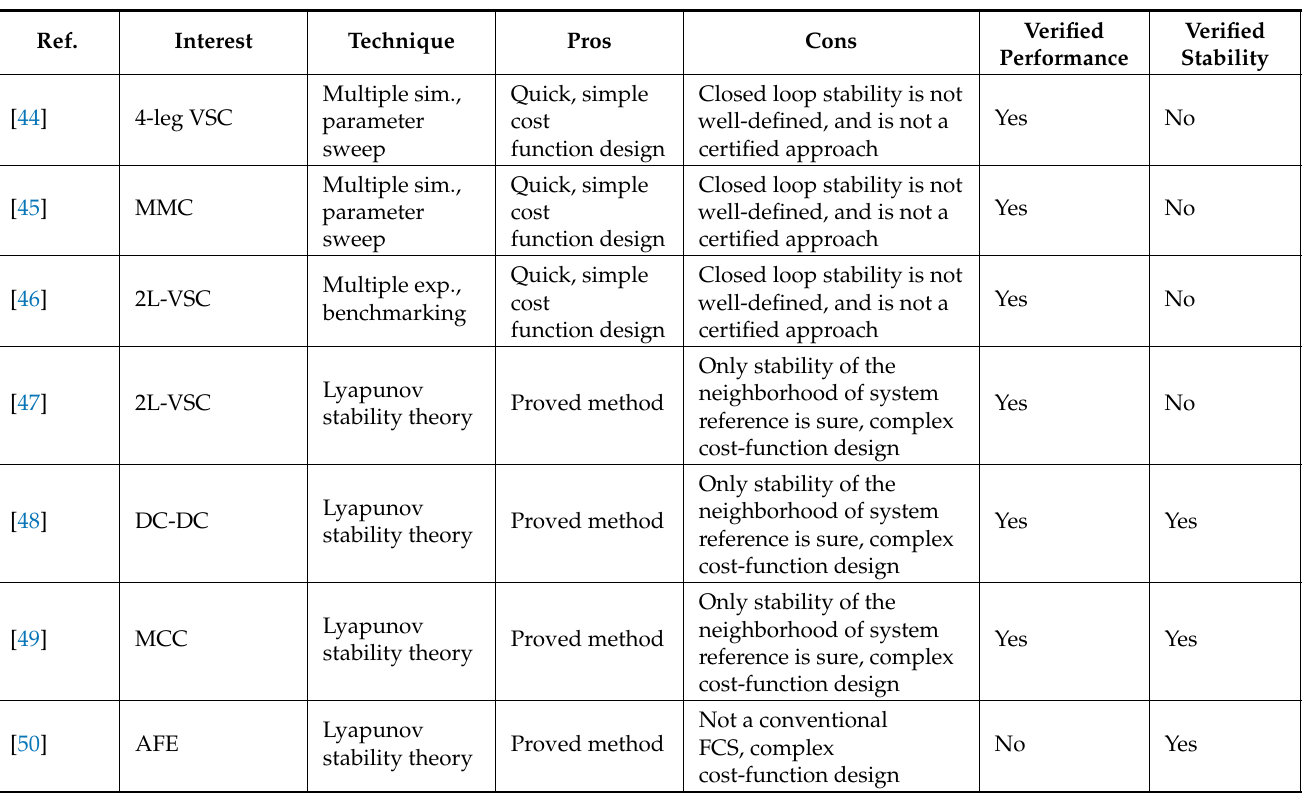
Table 2. Literature review of state-of-the-art stability and performance validation of FCS-MPC.